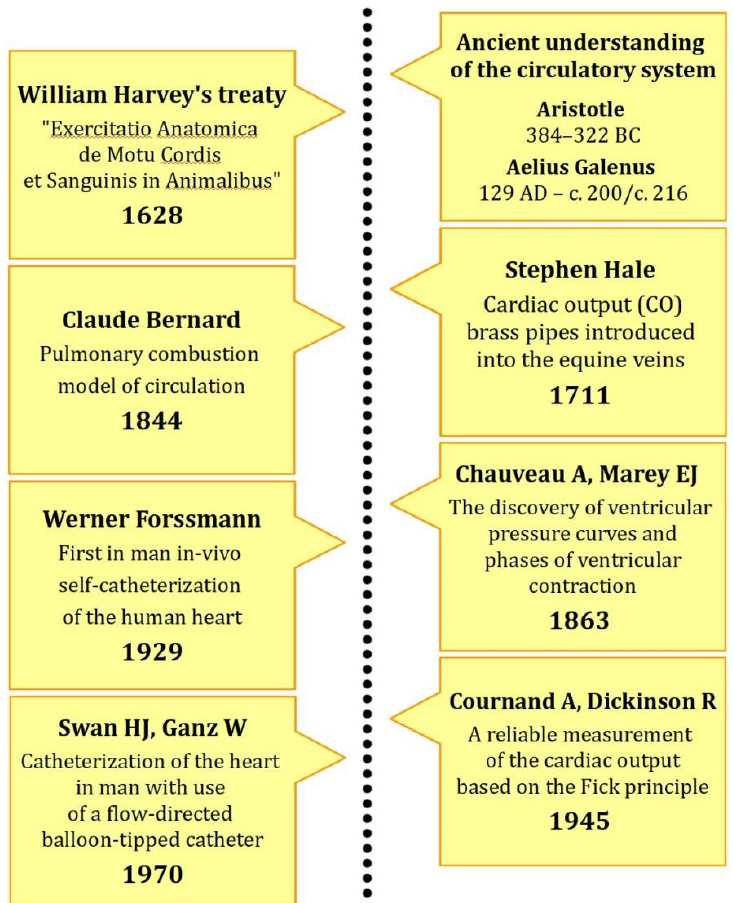
Figure 1. The milestones of right heart catheterization (RHC).